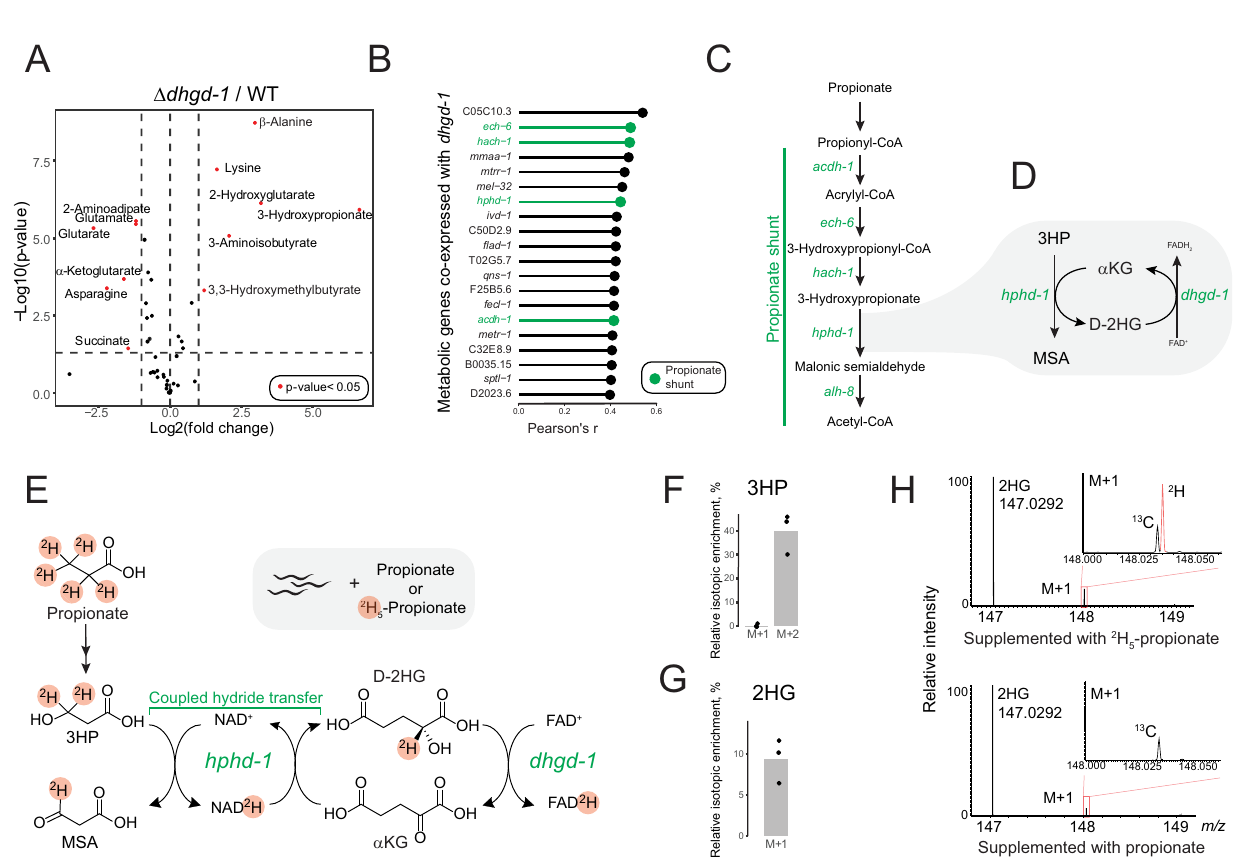
Fig 2. Dhgd-1 functions in the propionate shunt pathway. (A) GC-MS profiling of metabolic changes in Δ dhgd-1 mutants compared to WT C . elegans . P - values are Benjamini–Hochberg adjusted. (B) Metabolic genes most highly coexpressed with dhgd-1 . Propionate shunt pathway genes are enriched with an FDR of 0.042 (S2 Table). (C, D) Proposed mechanism of D-2HG production (by HPHD-1) and recycling (by DHGD-1) during propionate degradation via the propionate shunt pathway. (E) Isotope tracing experiment with deuterium ( 2 H)-labeled propionate and proposed reaction mechanism. HPHD-1 uses NAD + / NADH as a hydride shuttle in a coupled reaction yielding 1 equivalent each of MSA and D-2HG. (F, G) Fractional enrichment of 3HP (F) and 2HG (G) isotopologues. Bars indicate mean of n = 3 biological replicates. (H) HPLC-MS analysis of the M+1 isotope cluster in animals fed 2 H 5 -propionate revealed robust incorporation of a single deuterium atom in 2HG, whereas the M+1 in animals fed propionate was exclusively from natural abundance of 13 C. The data underlying Fig 2F and 2G can be found in S1 Data . D-2HG, D-2-hydroxyglutarate; FDR, false discovery rate; GC-MS, gas chromatography–mass spectrometry; HPLC-MS, high performance liquid chromatography mass spectrometry; MSA, malonic semialdehyde; WT, wild type.